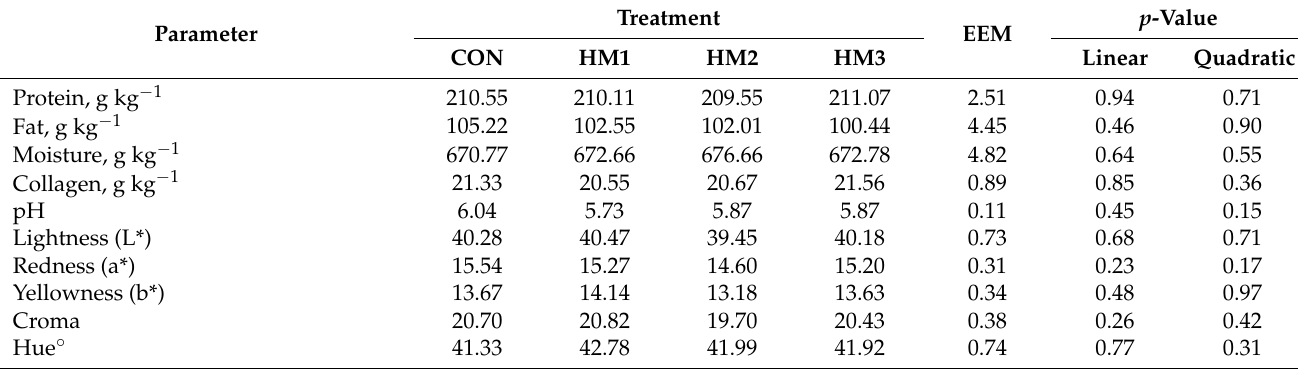
Table 4. Meat characteristics of lambs supplemented with a polyherbal mixture 1 during the final fattening period.